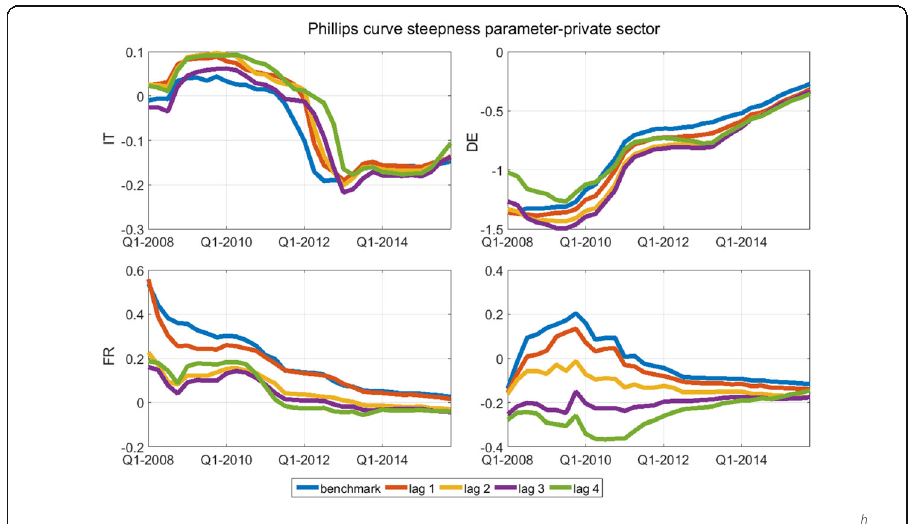
Fig. 7 Robustness to lag relationship between unemployment and wage dynamics Δ 4 w t ¼ c t þ